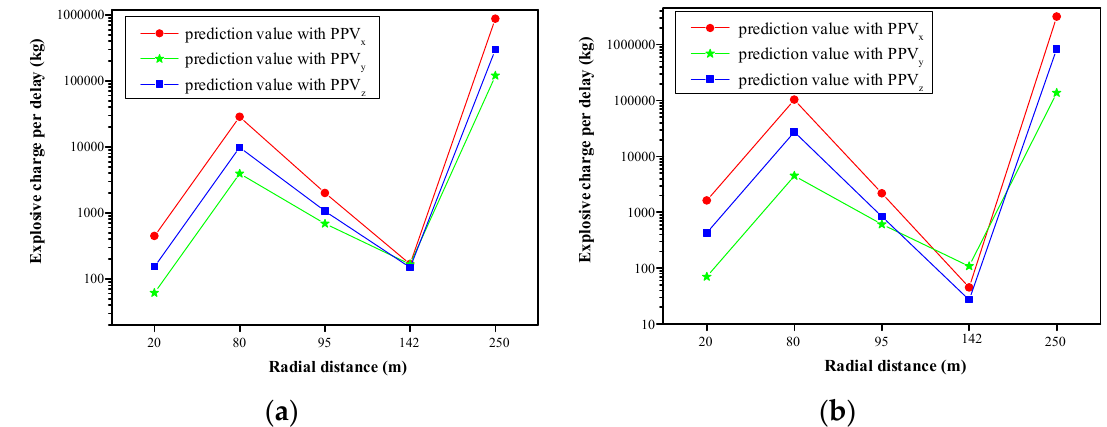
Figure 10. Prediction value of explosives charge weight per delay in different regions. ( a ) Region Ⅴ and ( b ) region Ⅵ .